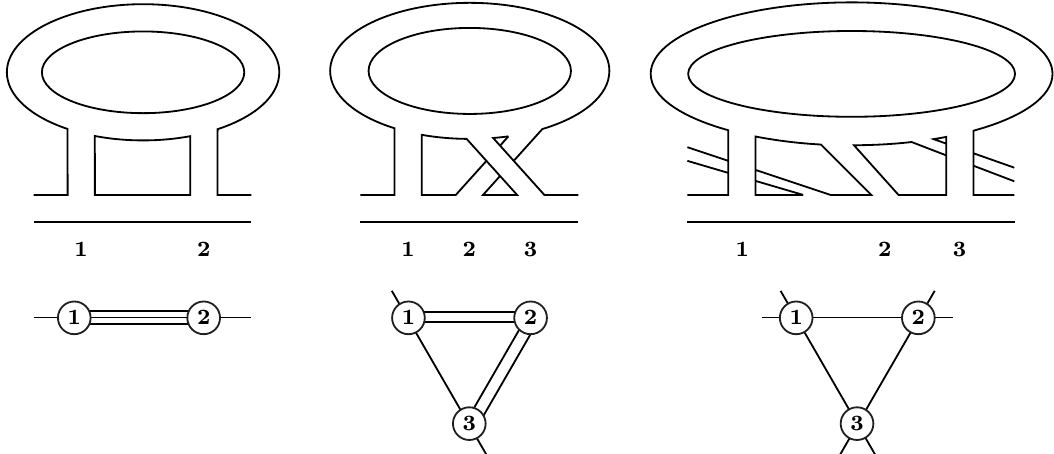
Figure 34 . Open two-points and edge-adjacency matrices represented as adjacency graphs for periodic